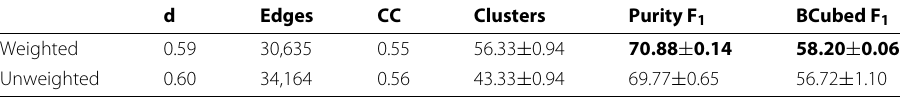
this representation is more discriminative than that of the argument on its own, the top performance on the development set is 58.20% in terms of BCubed F 1 , which shows that there is still a significant amount of semantic information that it is not able to capture or that the distance metric is not the most appropriate for capturing semantic